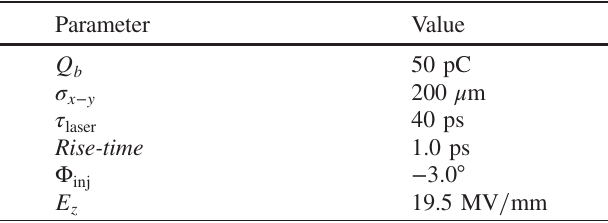
TABLE II. Gun working point parameters.